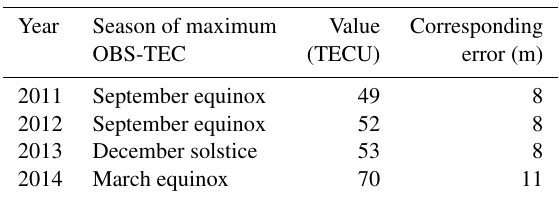
Table 3. Seasons of maximum OBS-TEC and their corresponding range